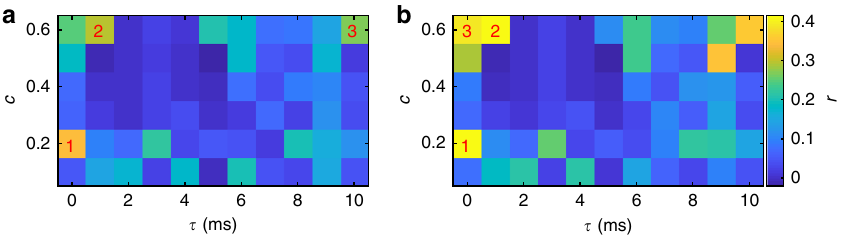
Fig. 9 Correlation between modeled and empirical functional connectivity as a function of coupling and delay. a Pearson ’ s correlation between empirical and modeled FC values for each pair of regions, without GSR. Numbers 1 – 3 indicate the top three highest correlations. b Same as a but